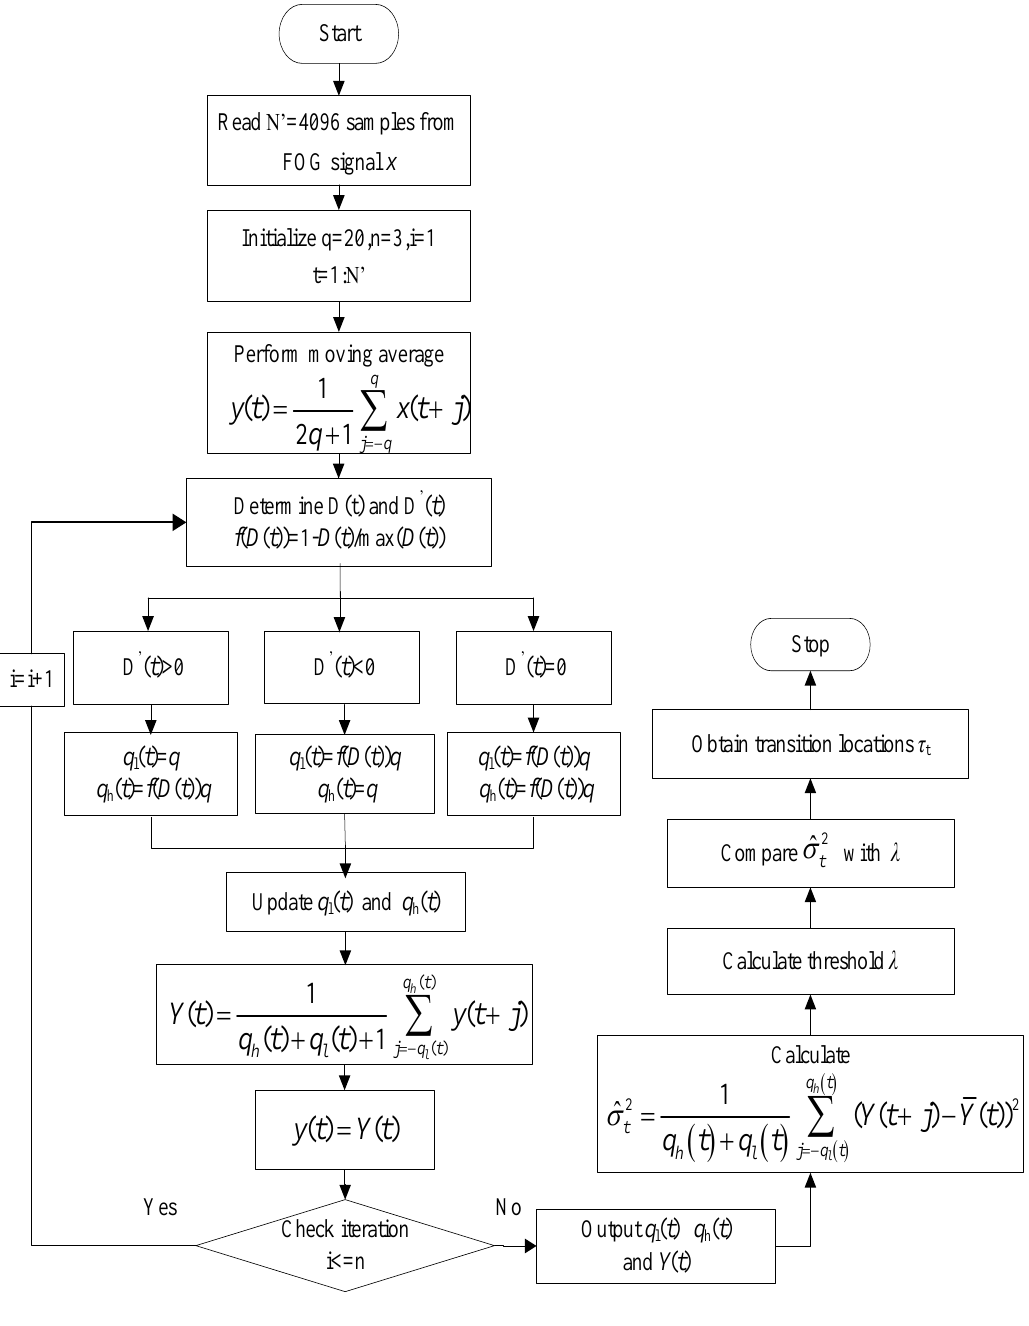
Figure 1. Procedure of the AMA